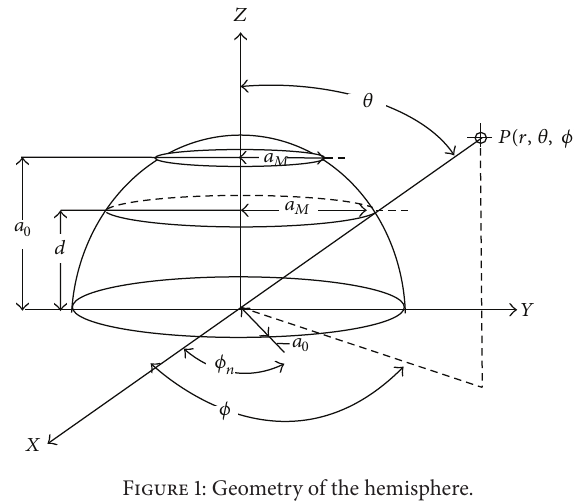
Figure 1: Geometry of the hemisphere.